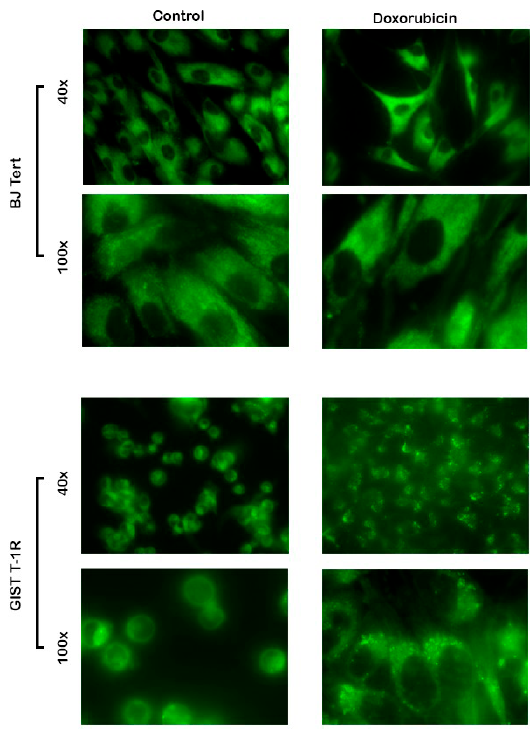
Figure 5. Changes in [BF 2 L]-mediated fluorescence as a potential marker of reorganization of Table 1. R cancer cells (lower panel) pretreated with doxorubicin (0.5 µg/mL) for 24 h or left untreated (control) prior to the [BF 2 L] exposure (1 h). The experiments were performed in triplicates. The images were shown at 40x and 100x magnifications for each experimental condition.